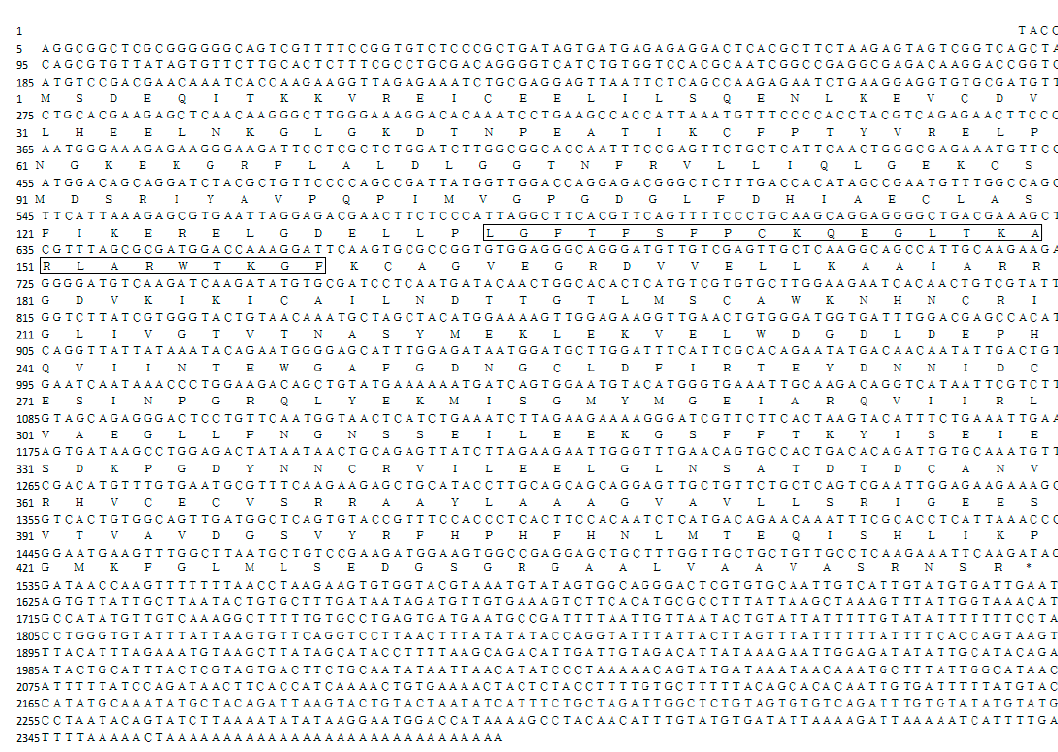
Figure 1. Nucleotide and predicted amino acid sequences for Macrobrachium nipponense hexokinase (HK) cDNA. HK signature sequences are shown in boxes. The asterisk indicates the stop codon.